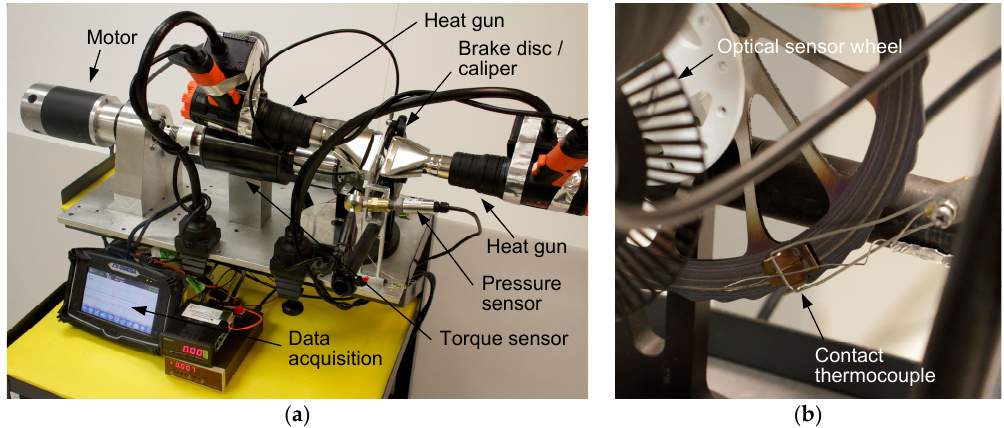
Figure 1. Brake dynamometer experimental setup: ( a ) Overall setup and data collection equipment; ( b ) the brake disc and contact